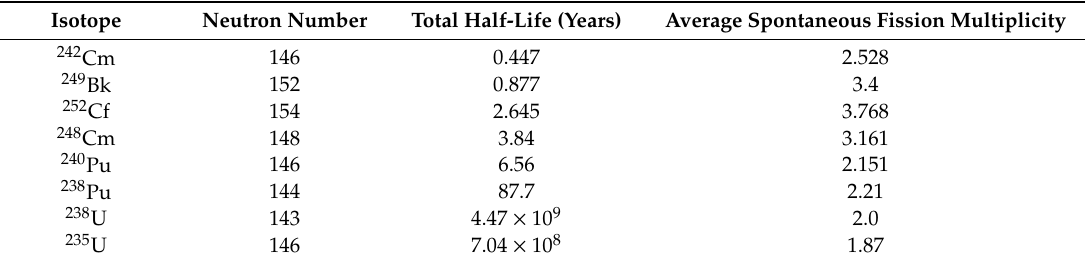
Table 2. Spontaneous fission isotopes and neutron multiplicity.